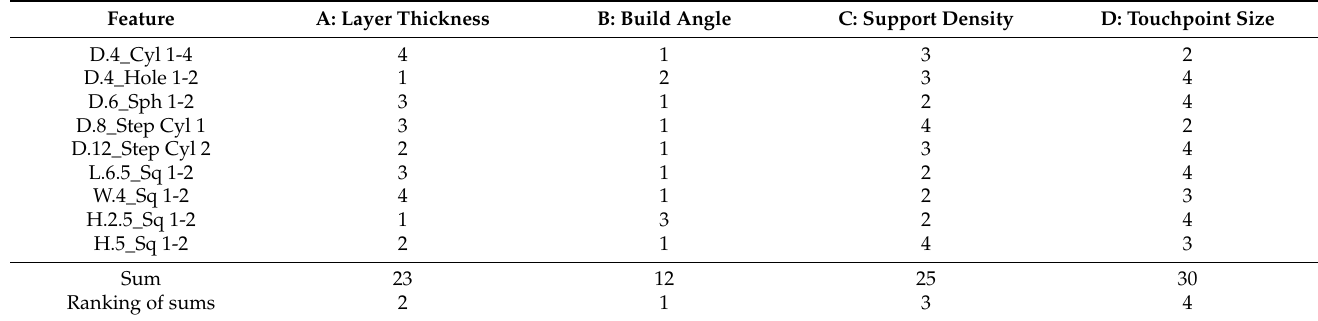
Table A3. Mean ranking of parameters for dimensional accuracy of cast parts.